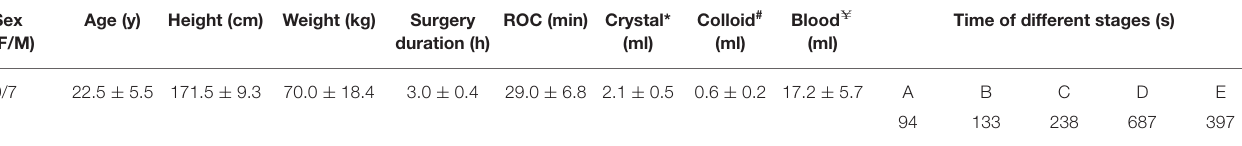
TABLE 1 | General information.